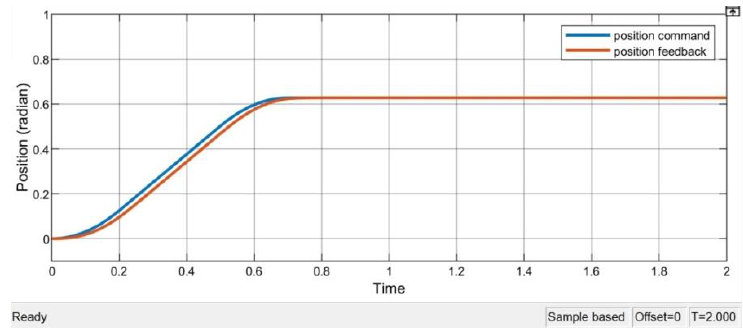
Figure 6. The position command and position response without load.